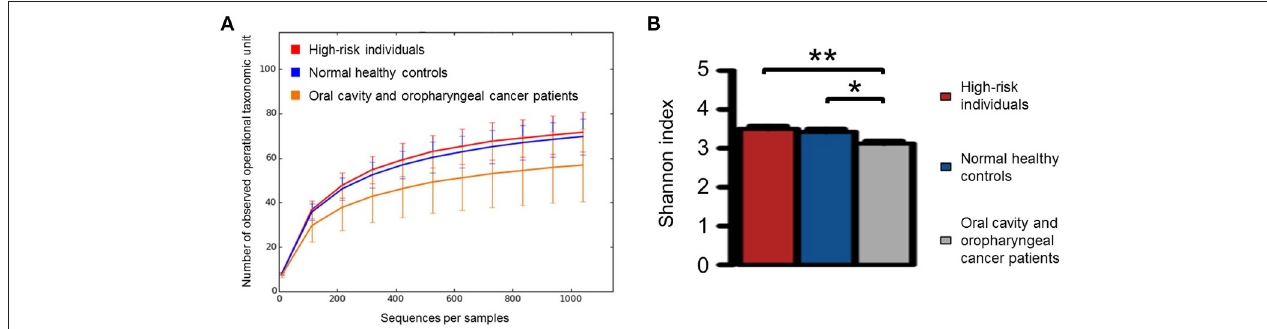
FIGURE 1 | (A) Rarefaction curve of observed operational taxonomic unites against sequences per sample for normal healthy controls ( n = 20), high-risk individuals ( n = 11), and oral cavity and oropharyngeal cancer patients ( n = 52) as well as (B) the comparison of Shannon index for each category using rank test. Significant differences are denoted with * P < 0.05 and ** P < 0.01, respectively.